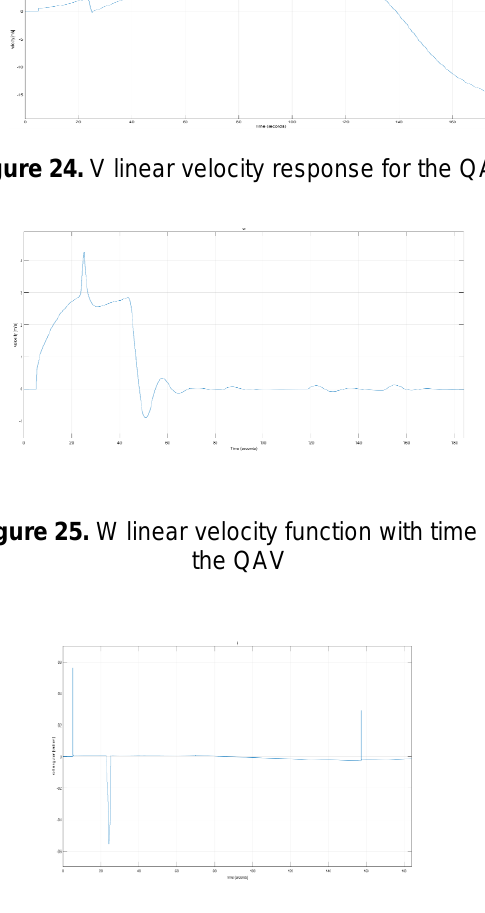
Figure 26. ϕ angle around X - axes for the QAV